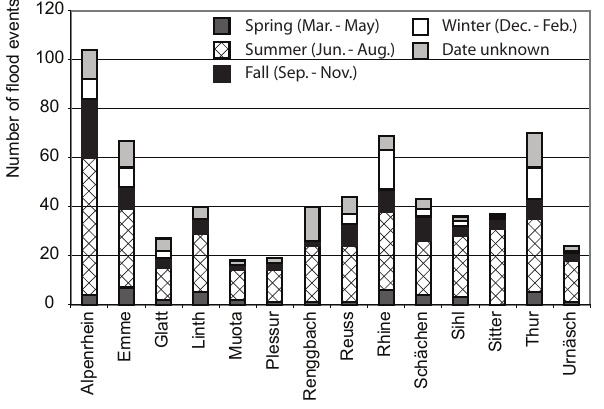
Fig. 4. Seasonal distribution of historic flood events for the period 1500–2007 in the 14 catchments studied. Summer floods dominate in all catchments.